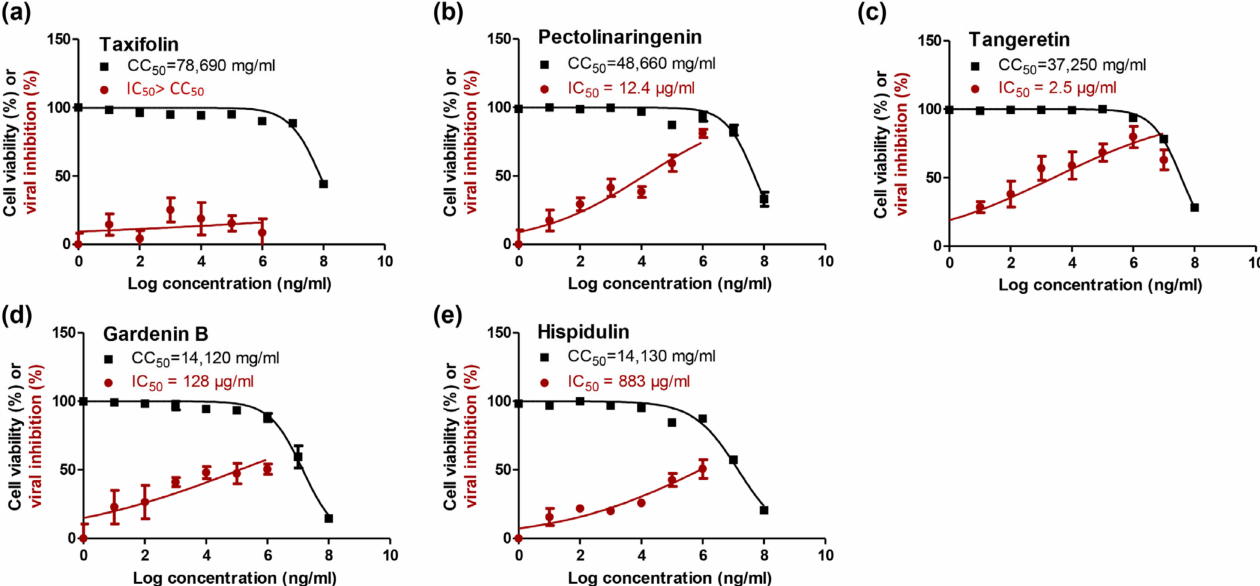
Figure 2. Dose-response and inhibition curves for the five isolated compounds (taxifolin ( a ), pectolinarigenin ( b ), tangeretin ( c ), gardenin B ( d ), and hispidulin ( e )) showing the half-maximal cytotoxic concentration (CC 50 ) in Vero E6 cells and inhibitory concentration 50% (IC 50 ) against NRC-03-nhCoV which were calculated using the nonlinear regression analysis of the GraphPad